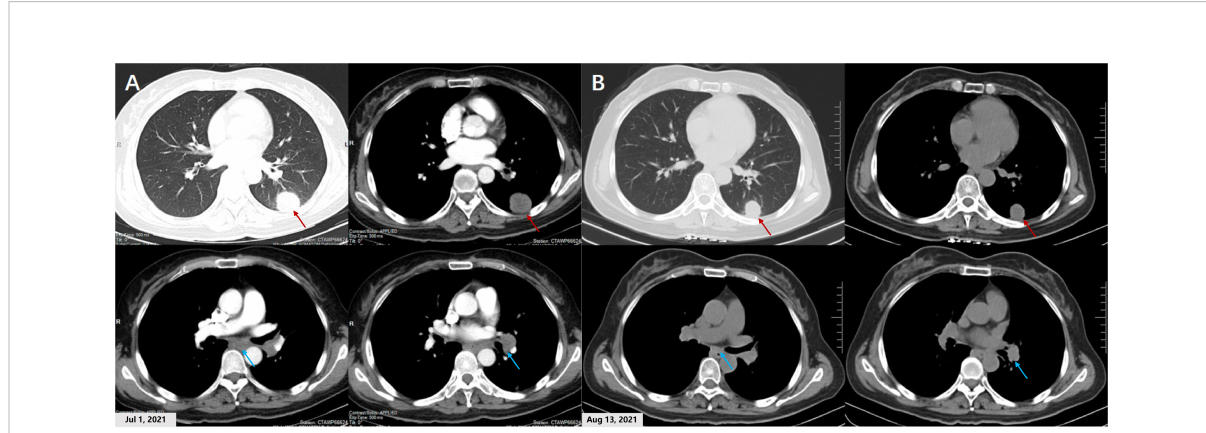
FIGURE 1 Chest CT scans of the patient before and after savolitinib treatment. (A) The chest contrast-enhanced CT scan on July 1, 2021 demonstrates a 3.8 cm × 2.9 cm abnormal lung mass (white arrows) in the lobe of left lung. Enhanced signal was not detected inside the mass. Left hilar and subcarinal lymphadenopathy (red arrows) also were observed. (B) After 21 days of savolitinib therapy, the chest CT scan on August 13, 2021 showed the mass (red arrows) had shrunk to 2.6 cm × 2.2 cm, achieving a partial response (PR). The Left hilar and subcarinal lymph node (blue arrows) also shrank signi fi cantly, and the short diameter did not exceed 7